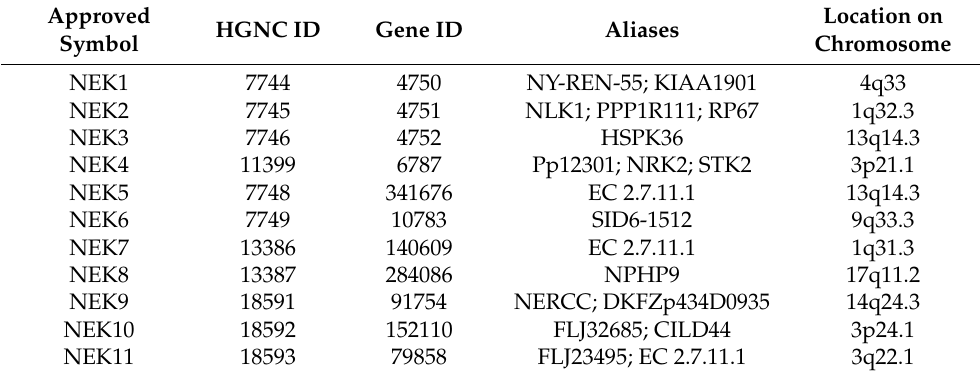
Table 1. Basic Characteristics of the NEK Genes